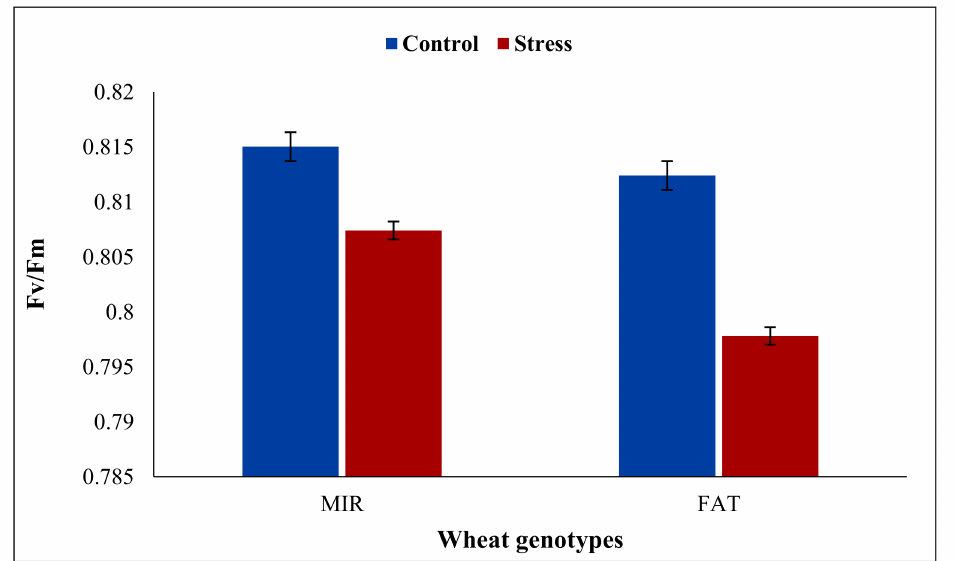
Figure 3. Effect of 150 mM NaCl on the Fv/Fm parameter (maximum quantum yield of PS II) in dark-adapted leaves of salt-tolerant Mirbashir 128 (MIR) and salt-sensitive Fatima (FAT) wheat genotypes after 10 days of treatment. The values of standard error ( ± SE) in each bar were calculated for each treatment from three